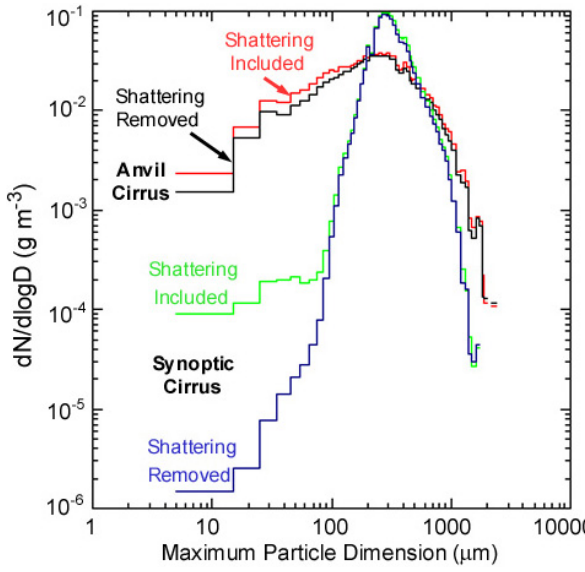
Figure 12. Particle size distributions as a function of concentration from 2D-S probe Fig. 12. Particle size distributions as a function of concentration measurements in anvil and synoptic cirrus sampled on 14 April 2011 from 183600 – 185100 UTC (synoptic cirrus), and 11 April 2011 from 173750 – 184610 UTC (anvil cirrus) by the from 2D-S probe measurements in anvil and synoptic cirrus sam- NASA WB-57 during the MACPEX field campaign. Example 2D-S images from each time pled on 14 April 2011 from 18:36:00–18:51:00UTC (synoptic cir- period are shown below the size distributions. rus), and 11 April 2011 from 17:37:50–18:46:10UTC (anvil cirrus) The data in Fig. 12 are also a good example of how quoting multiplicative shattering by the NASA WB-57 during the MACPEX field campaign. Exam- factors can be very misleading. The shattering algorithm reduces the total number concentration in the synoptic cirrus by an order of magnitude (i.e., from 109 L -1 to 11 L -1 ), ple 2D-S images from each time period are shown below the size while the anvil particle concentration is only reduced by 32% (i.e., from 3,017 L -1 to 2,059 L - distributions.